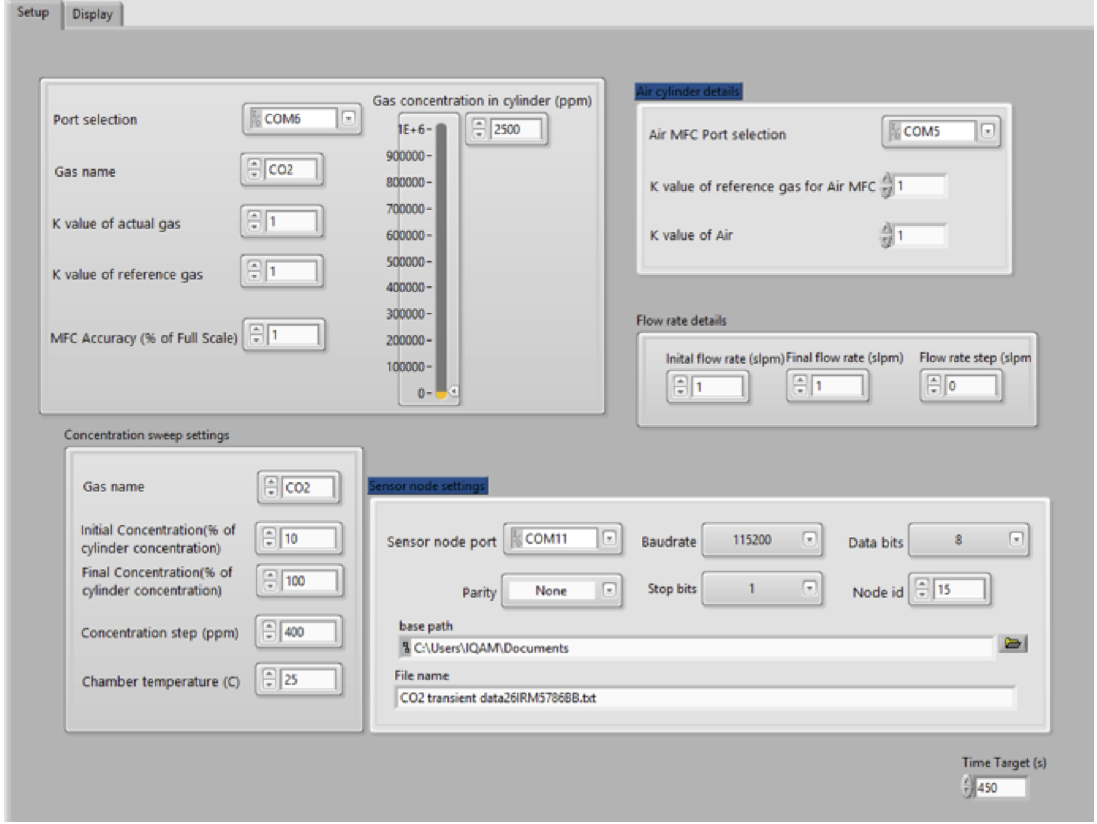
Figure 4. LabVIEW VI running the calibration rig during data collection phase.